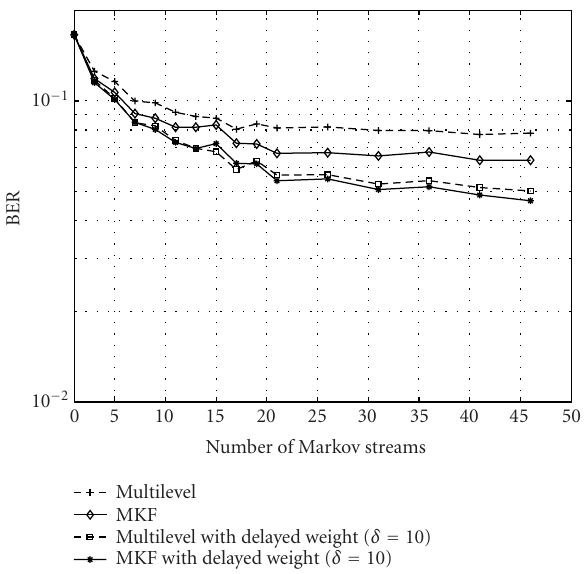
Figure 5: The BER performance of the MKF, and the multilevel MKF for di ff erential 16-QAM over flat-fading channels versus the number of Markov streams. The delayed-weight method is used with δ = 10.